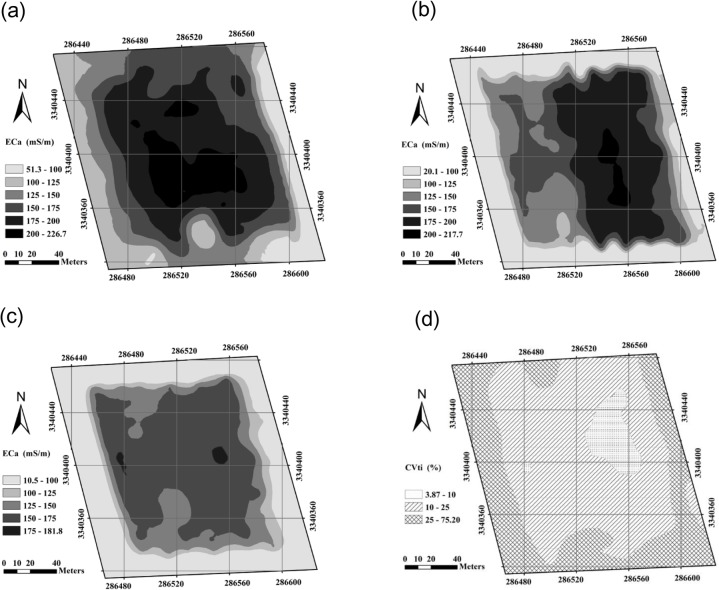
Spatial distribution of soil ECa (mS/m) in (a) 2009, (b) 2010, and (c) 2011.The plot of (d) coefficient of variation (CVti) over three years.